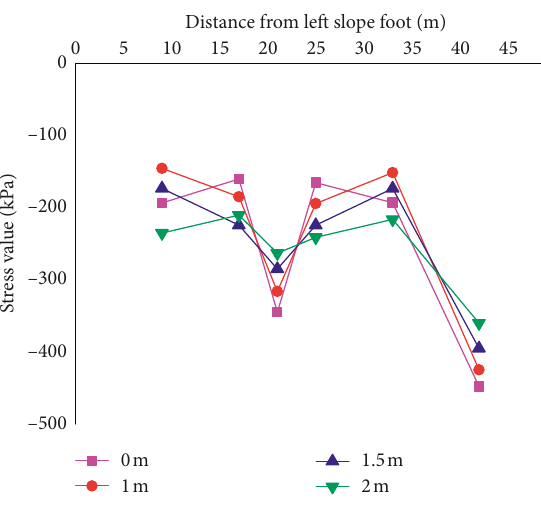
Figure 8: Distribution curve of base